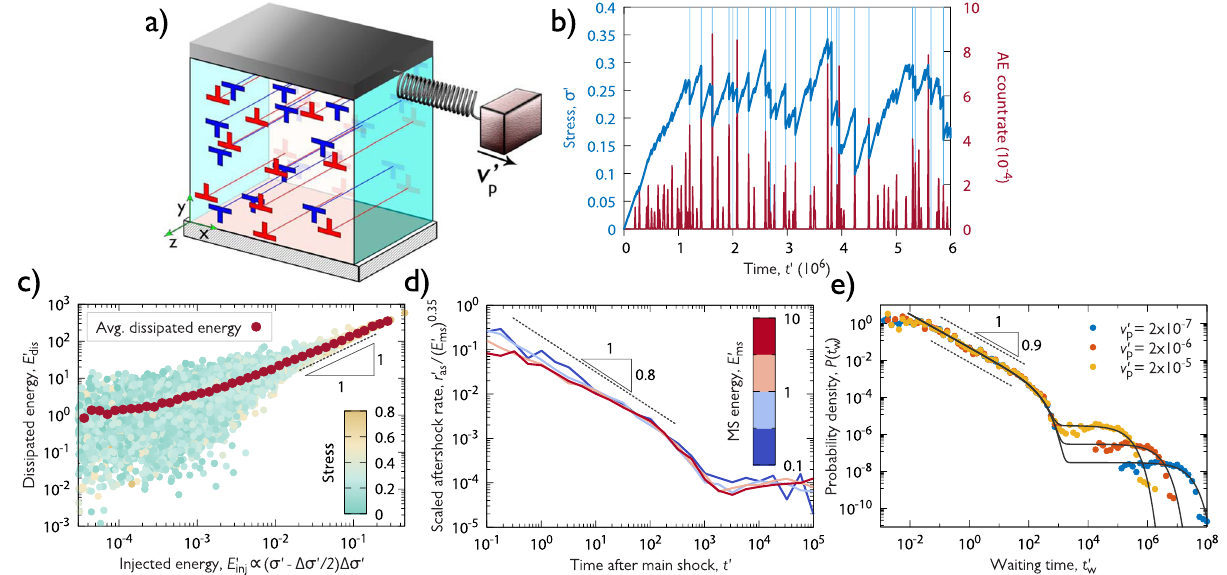
Fig. 4 DDD simulations. a Sketch of the simulation set-up. The system is in fi nite in direction z and periodic boundary conditions are applied in directions x and y . b Stress vs. time curve as well as the averaged rate of the simulated individual AE bursts for a representative con fi guration. The light blue vertical lines show the stress drops larger than 0.02. c Scatter plot of the injected energies during stress drops and the corresponding summed released AE energies for systems of N = 1024 dislocations, see caption of Fig. 2c for details. d The rate of aftershocks r 0 energy E 0 given by the colour for N = 1024 dislocations (Omori and productivity laws). e PDF P ð t 0 ms v 0 p